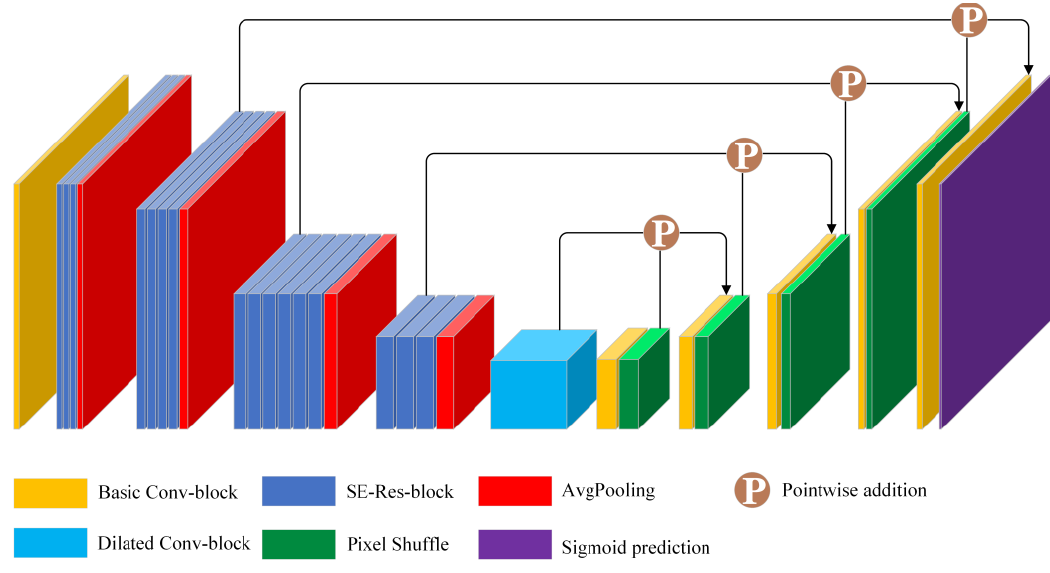
Figure 3. Structure diagram of DSDNet.